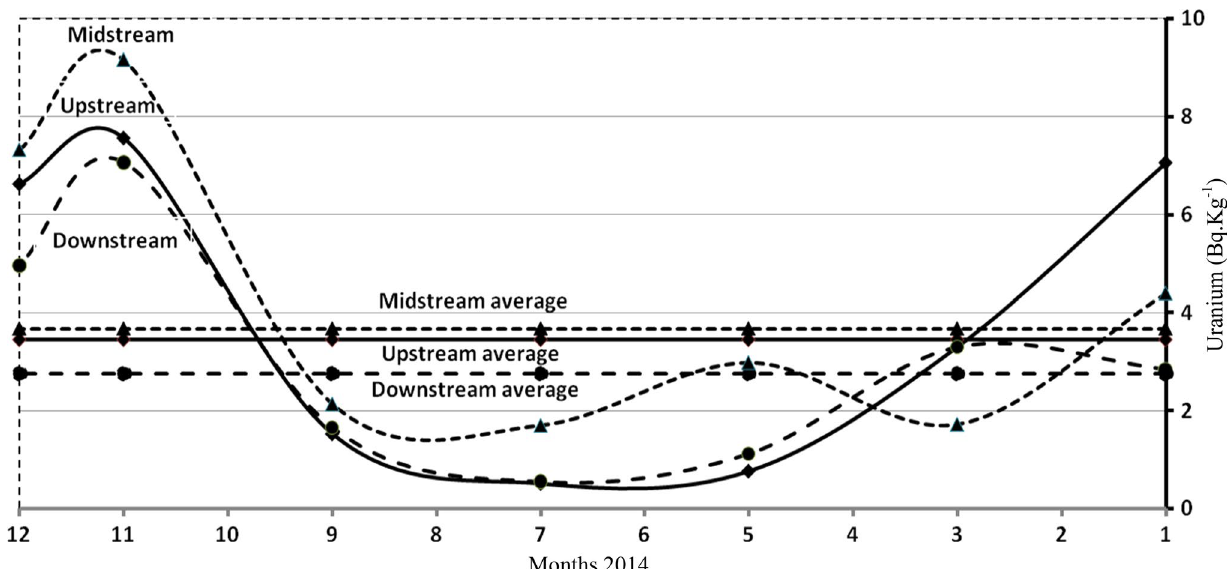
Fig. 3 Uranium contents (Bq Kg −1 ) of Tigris River sediment at a three sites along Baghdad city area during the period from November 2013 to June